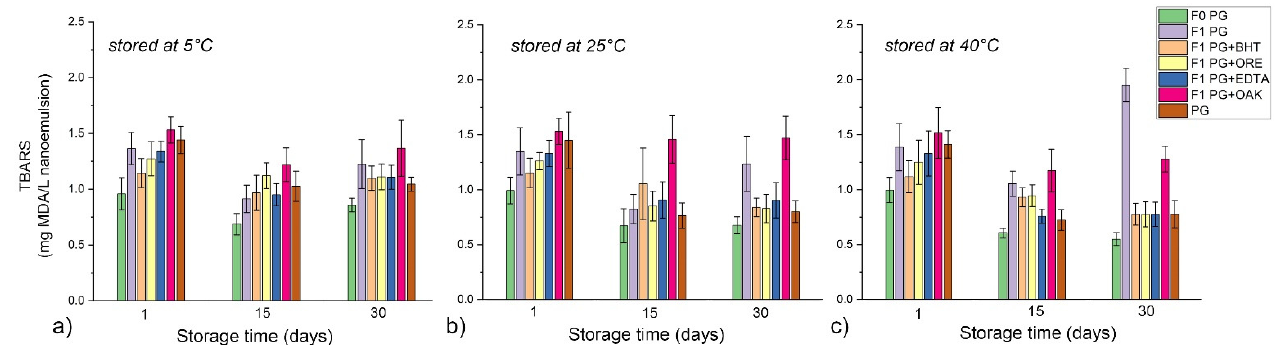
Figure 8. Thiobarbituric reactive substances—TBARS of polysorbate 80 dispersion in water (P80) and P80-stabilized NEs during one month of storage at different temperatures: ( a ) 5 °C, ( b ) 25 °C, and ( c ) 40 °C.